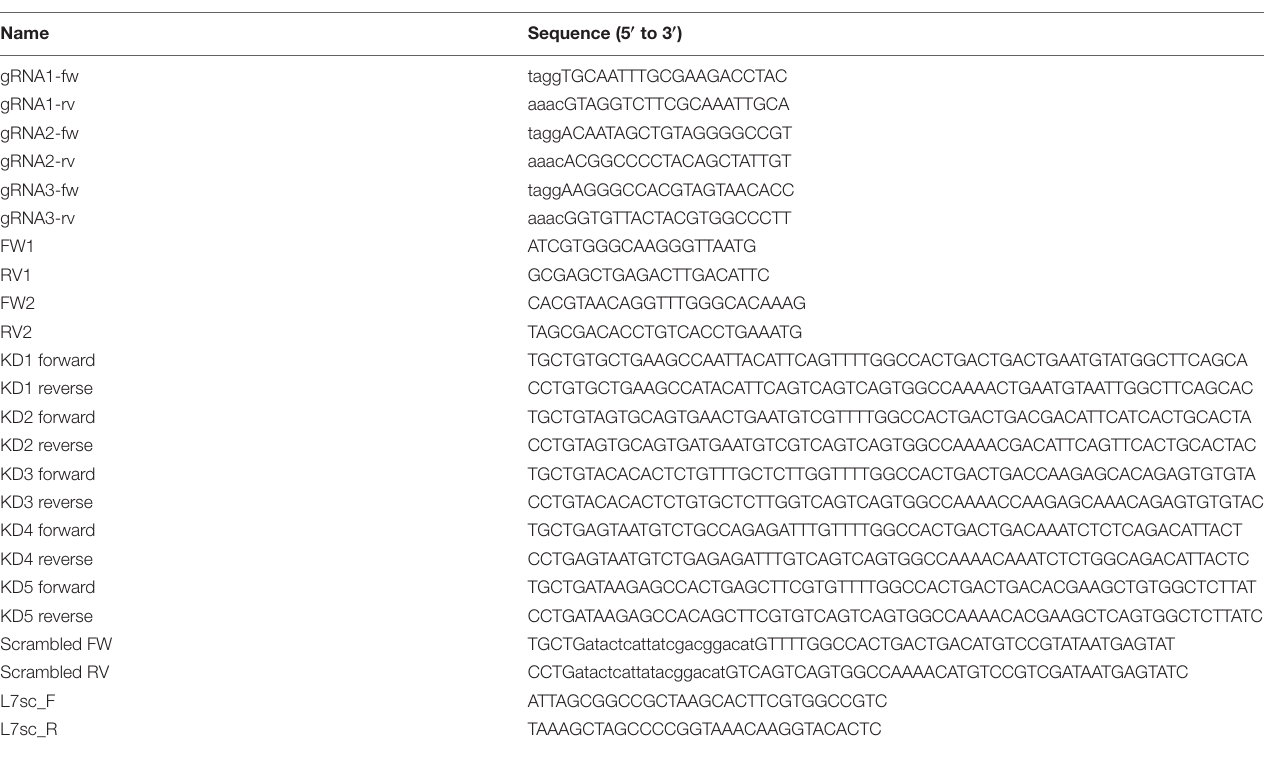
TABLE 2 | Oligonucleotides used in this